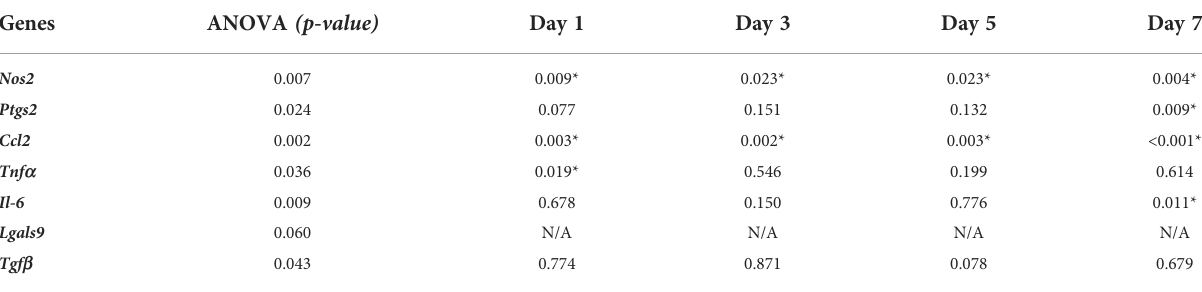
TABLE 3 AD-MSC phenotype retention after IFN g licensing pairwise comparison. Holm-Sidak Pairwise Comparison (vs. Control)